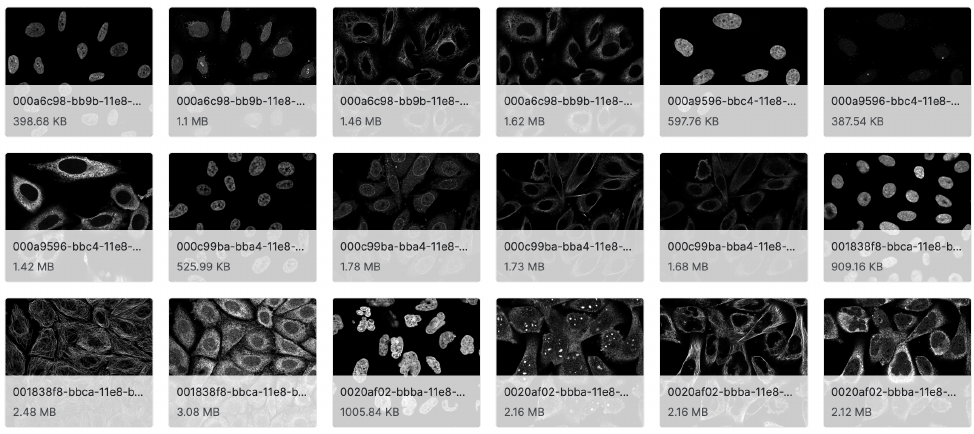
Figure 2. Sample of the dataset